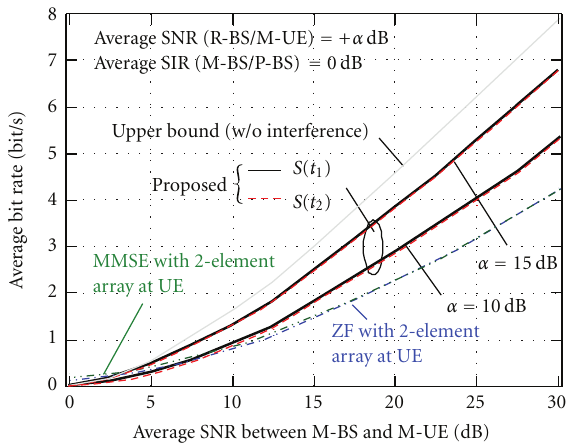
Figure 8: Transmission rate versus SNR between M-RS and M-UE.